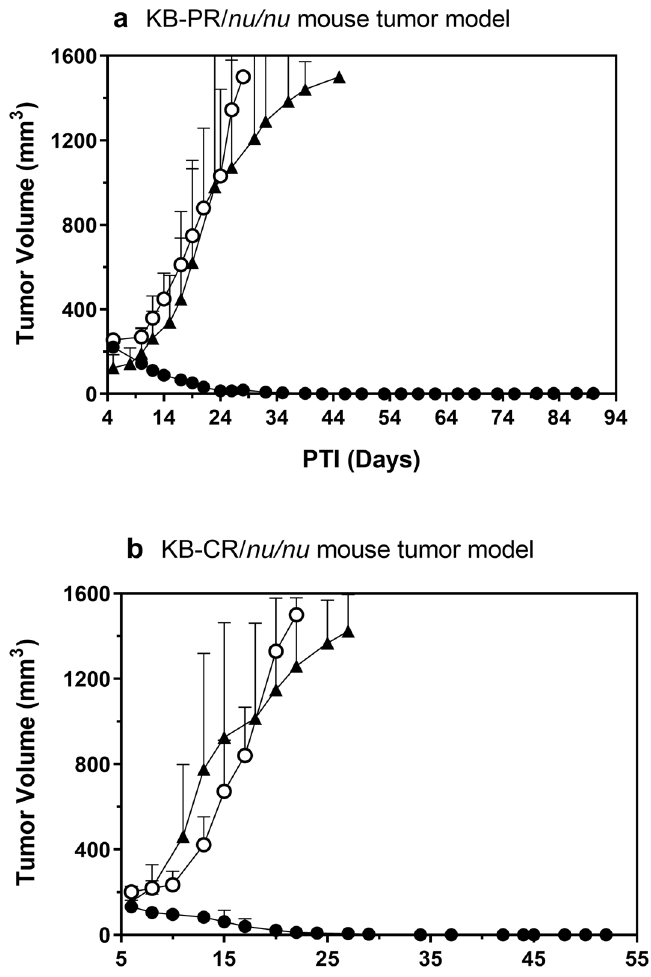
Figure 4. Antitumor effects of EC2629 on FR expressing KB-PR ( a ) and KB-CR ( b ) tumors in nu/nu mice. KB-PR ( a ) or KB-CR ( b ) tumor cells (1 × 10 6 ) were inoculated subcutaneously into nu/nu mice and therapy started on randomized animals with tumors in the 205–243 mm 3 ( a ) and 98–168 mm 3 ( b ) range. open circle, untreated controls; filled triangles ( a ), paclitaxel, 20 mg/kg, TIW × 2 weeks ( b ) cisplatin, 3 mg/kg, BIW × 2 weeks; filled circle, EC2629, 0.5 µmol/kg, SIW × 2 weeks. Each curve shows the average volume of 4–5 tumors; bars,